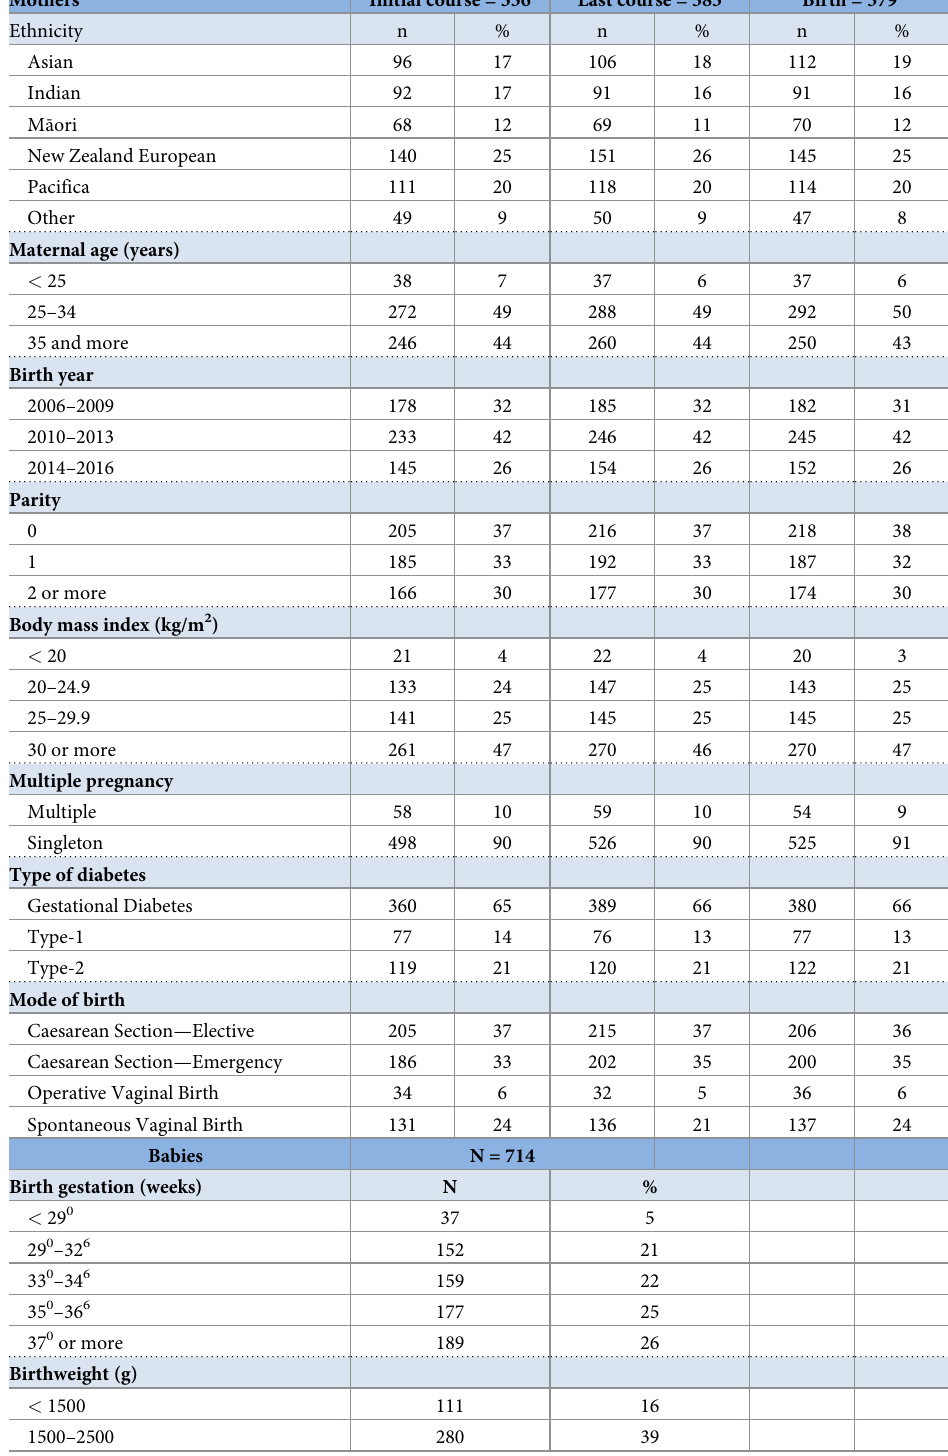
Table 1. Characteristics of women with diabetes in pregnancy who received antenatal corticosteroids and their babies for whom glycaemic data were